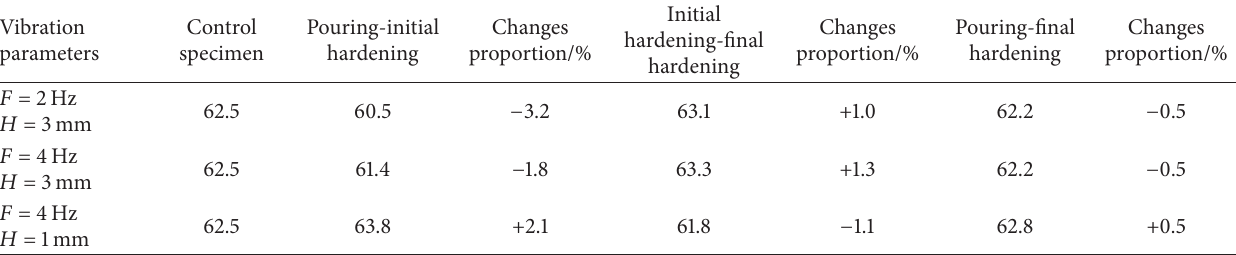
Table 6: Freeze-thaw cycles with 300 dynamic modulus and change